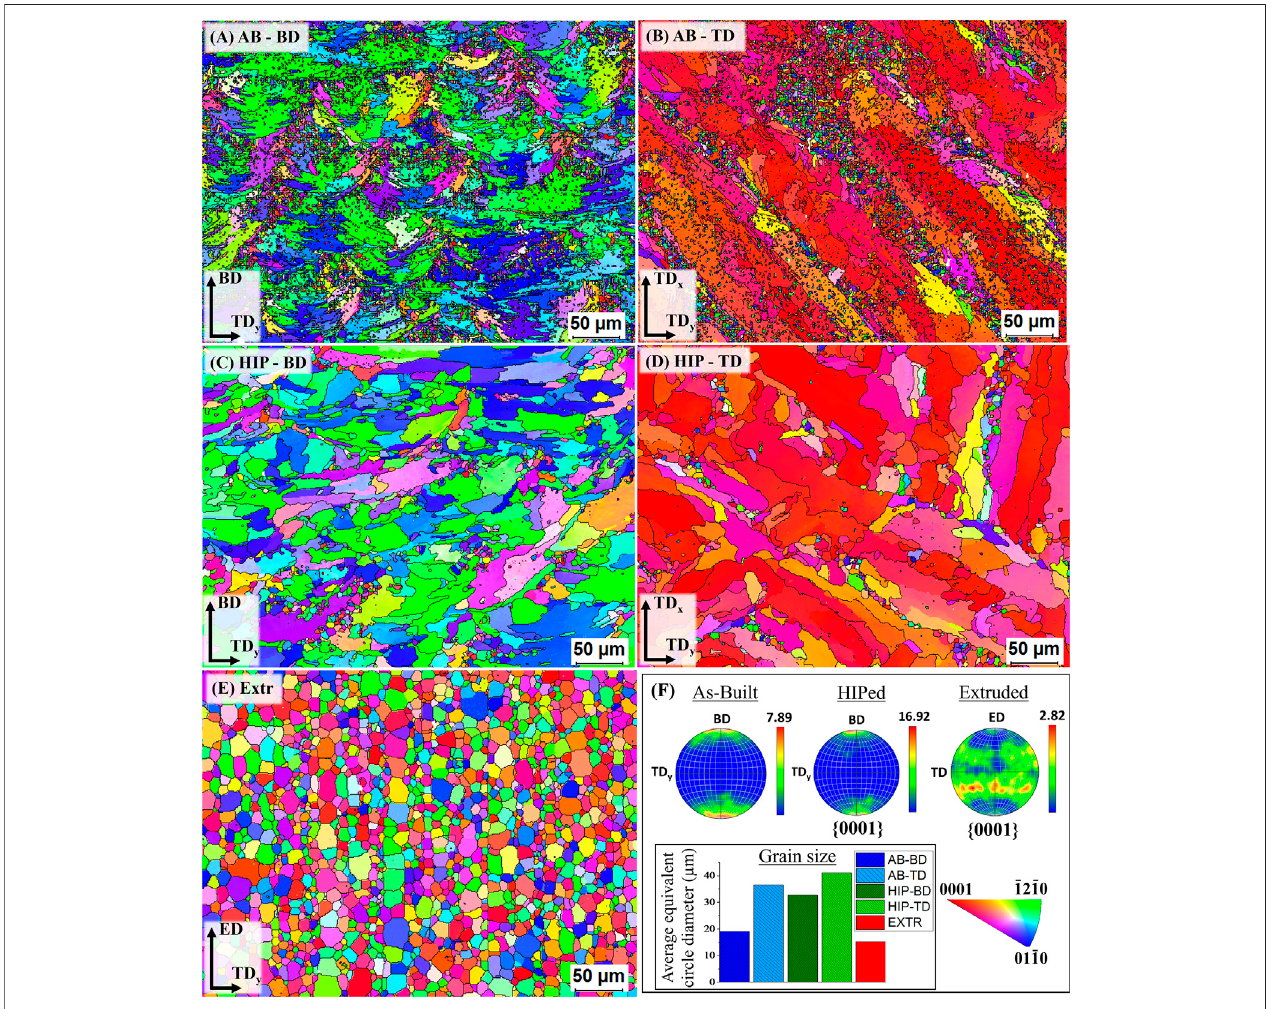
FIGURE 5 | IPF color maps of the AB (A , B) HIP (C , D) and Extr (E) material, together with the pole fi gures (F) .